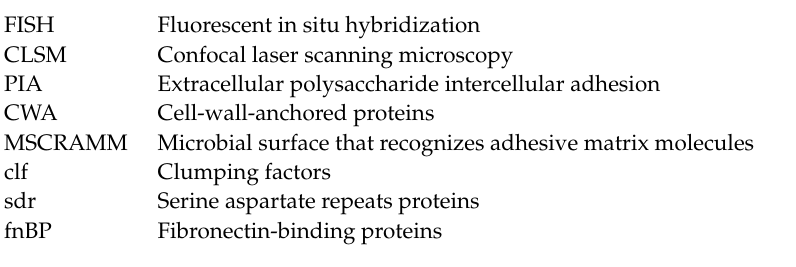
gene profile, and antibiogram of PN35 and HU13N clinical isolates. Table S2: Primers used for the construction of in-frame deletions of clfA and clfB, for the construction of triple deletion